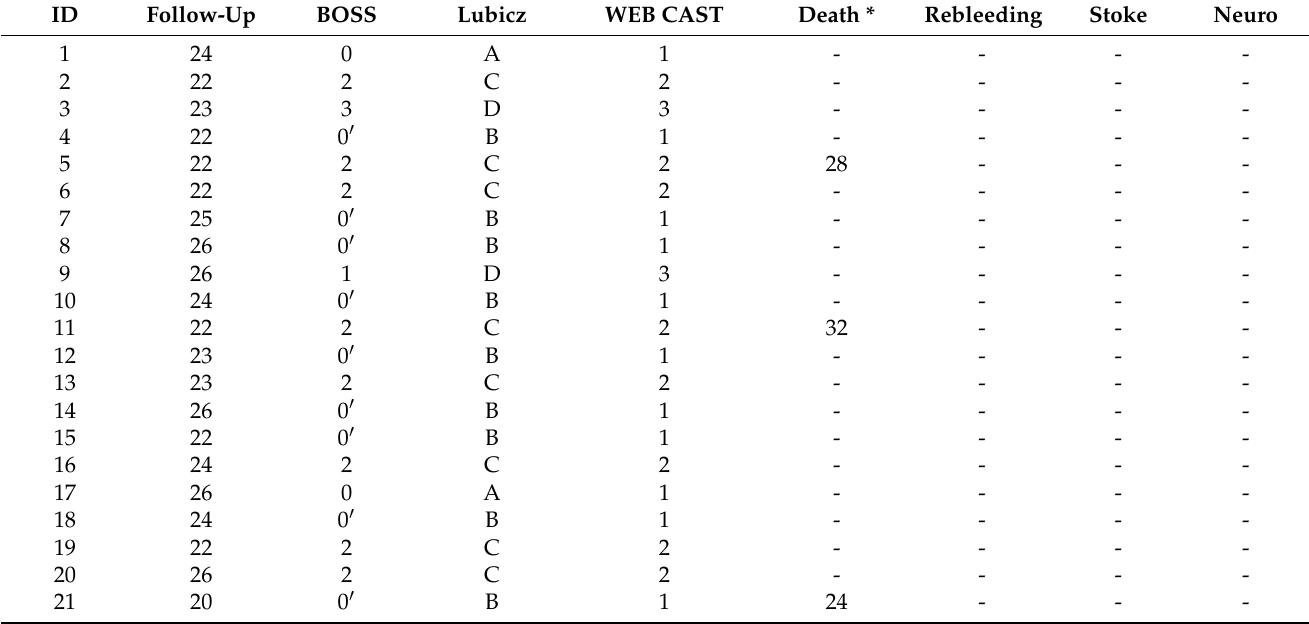
Table 5. WBNA occlusions according to different WEB scales, mortality rate, and neurological adverse effects at 2-year